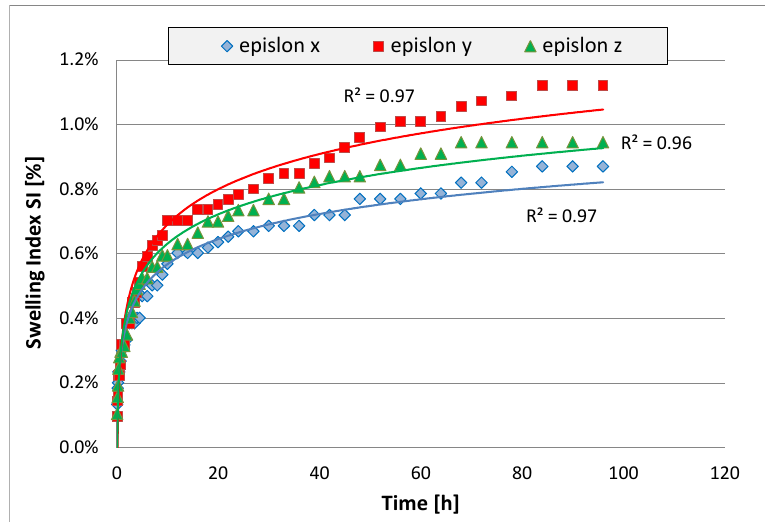
Figure 20. An example of results of swelling test on claystone from roadway F-33.